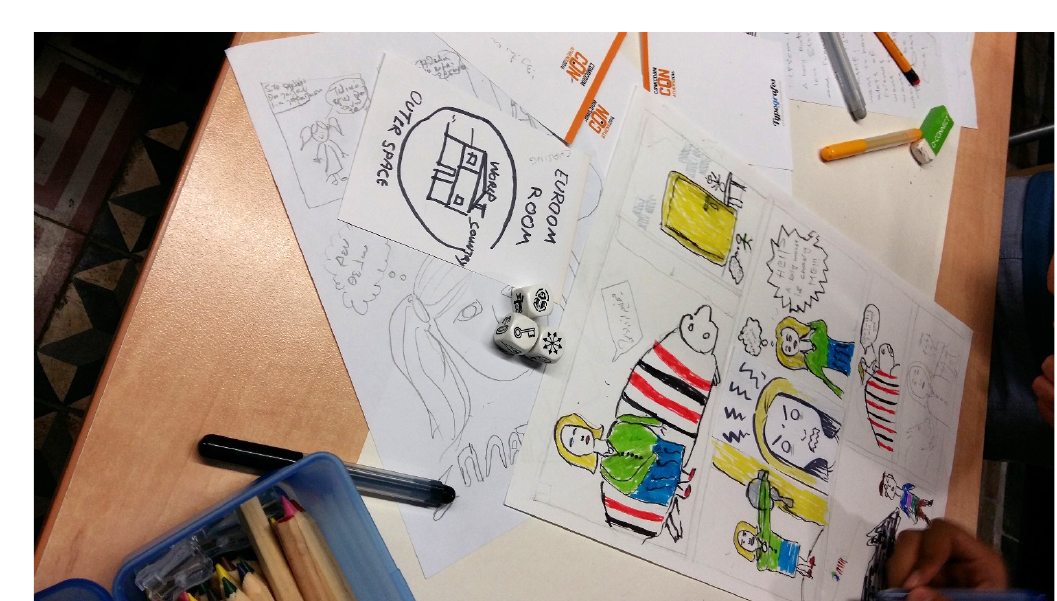
Figure 2. Collaboration during the Athens Comics Library’s